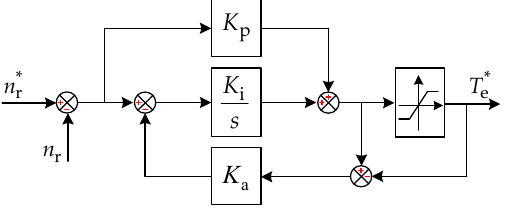
Figure 11. PI controller with anti-windup in speed loop.